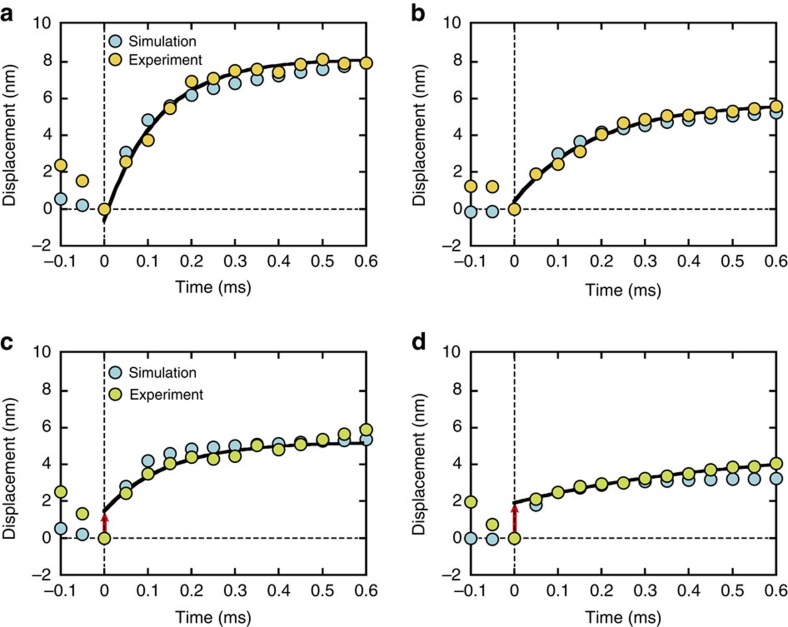
Characteristics of step curves during the rising phase of actin displacement.(a,b) Ensemble-averaged displacement of actin filaments at 1 mM ATP for low loads (mean of 2.7 pN, n=42 for experiment; mean of 2.5 pN, n=2,455 for simulation) in a and high loads (mean of 23.1 pN, n=179 for experiment; mean of 18 pN, n=487 for simulation) in b. (c,d) Ensemble-averaged displacement of actin filaments at 10 μM ATP for low loads (mean of 4.3 pN, n=51 for experiment; mean of 2.7 pN, n=404 for simulation) in c and high loads (mean of 28.6 pN, n=169 for experiment; mean of 22.7 pN, n=545 for simulation) in d. The black lines are single exponential curves (d=ds{1−exp[−t/τ]}+d0) fitted to experimental data starting from one sampling point after the onset point (t=50 μs). The fitting curves extended to t=0 pass close to the origin for 1 mM ATP (d0=−0.6 or 0.4 nm, ds=8.7 or 5.3 nm and τ=120 or 180 μs for low and high loads, respectively), suggesting that the entire rising phase of actin displacement can be approximated by a single exponential event, owing to the nearly coordinated executions of power strokes among multiple myosin molecules (Supplementary Fig. 6a,b). As indicated by the red arrows for 10 μM ATP, the fitting curves deviate from the origin (d0=1.5 or 1.9 nm, ds=3.7 or 3.0 nm and τ=150 or 495 μs for low and high forces, respectively), indicating that the rising phase can be divided into at least two phases: the first power stroke execution, followed by the second power stroke (Supplementary Fig. 6c,d).